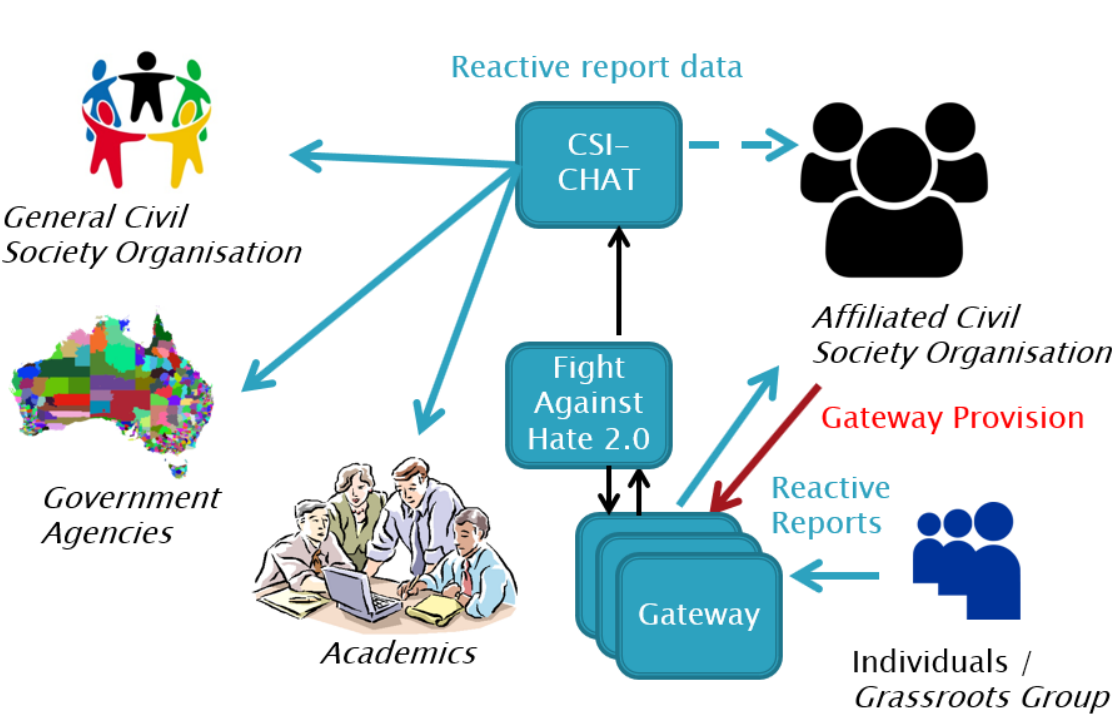
Figure 3: Technology’s Role in the SMARTER